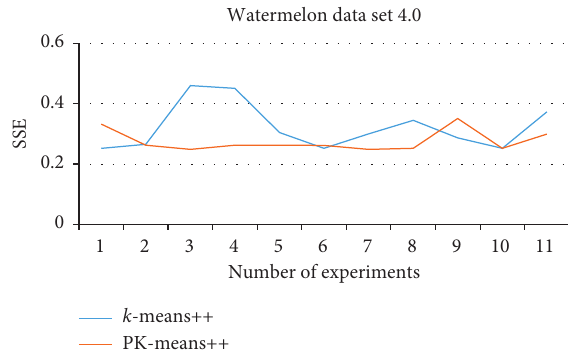
Figure 11: Comparison of the SSE on Watermelon Data Set